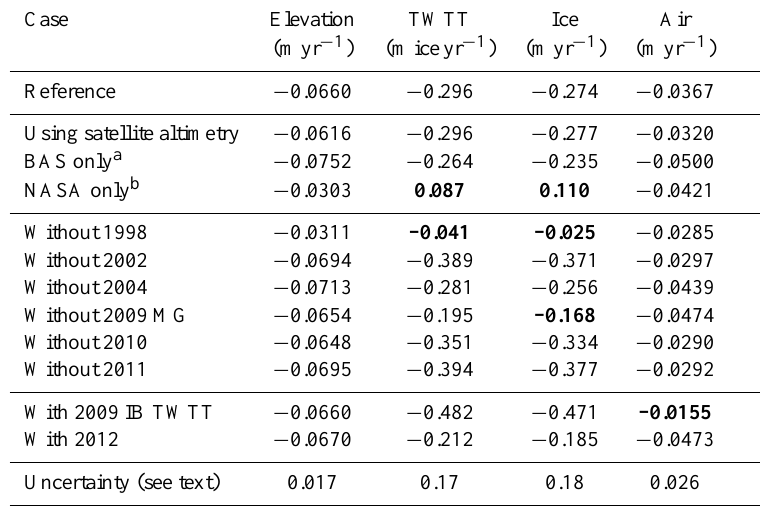
Table 2. Elevation and TWTT trends and their derived ice and air trends from calculations performed using different combinations of data. TWTT trends are expressed as solid-ice thickness equivalent. Trends in bold are smaller than the derived uncertainty (see main text). Case Elevation TWTT Ice Air (myr − 1 ) (miceyr − 1 ) (myr − 1 ) (myr − 1 ) Reference − 0.0660 − 0.296 − 0.274 − 0.0367 Using satellite altimetry − 0.0616 − 0.296 BAS only